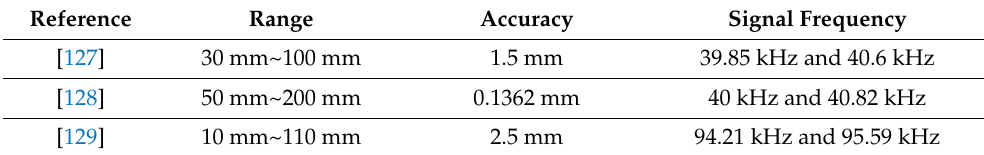
Table 3. Performance comparison of several TFCW based ranging systems.